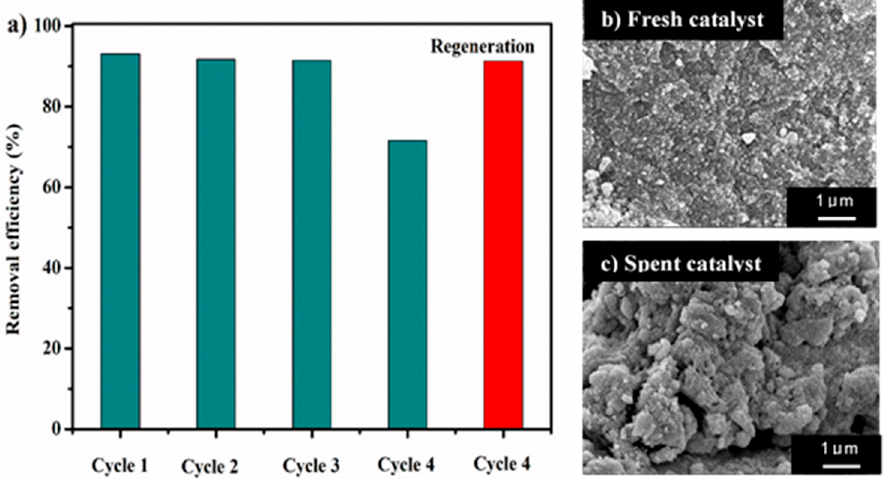
Figure 6 . ( a ) Reusability and regeneration performance test of 0.5CN/TiO 2 for imidacloprid degra- dation, SEM images of ( b ) fresh and ( c ) spent 0.5CN/TiO 2 photocatalyst Table 1. Comparative photocatalytic degradation of imidacloprid pesticide at varying conditions, over various carbon nitride based